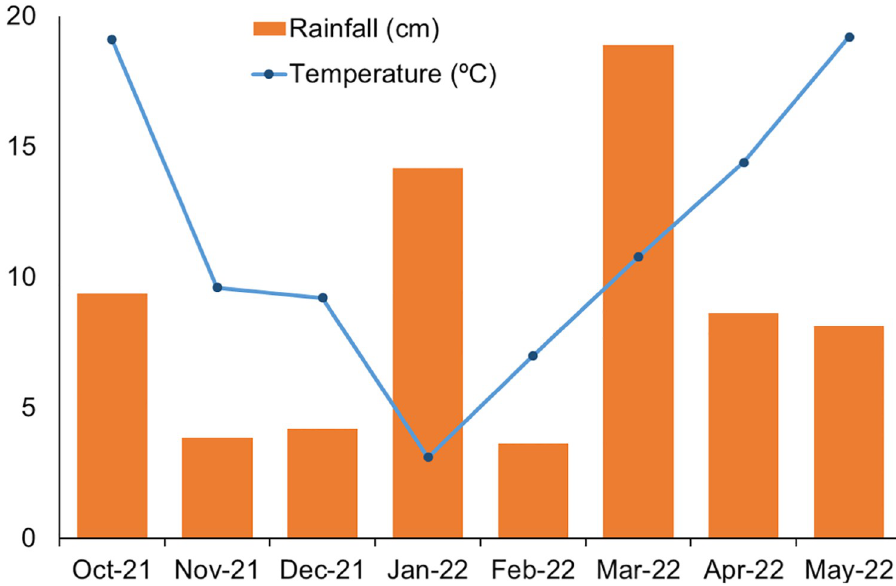
Fig 2. Monthly average temperature and rainfall during the experiment duration. Rainfall does not include 37cm snowfall received during Jan 2022.